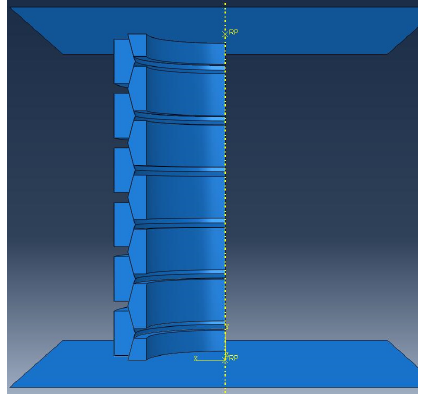
Figure 3. Finite element model of ring spring.